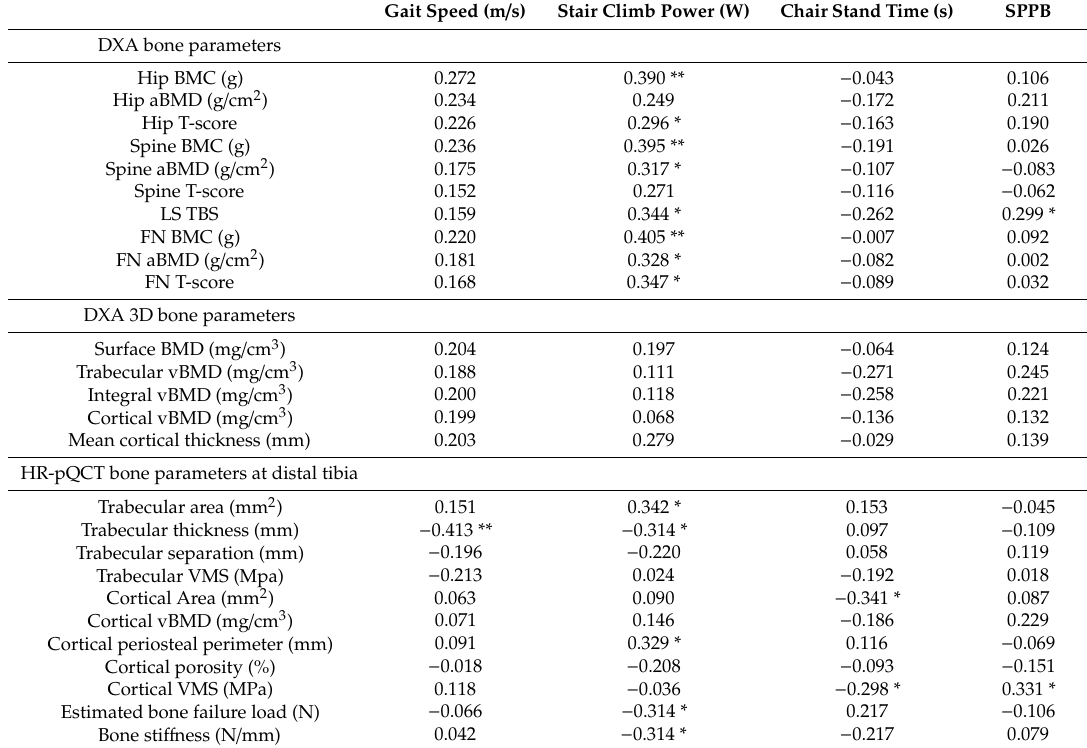
Table 3. Spearman’s correlations between objective measurements and bone